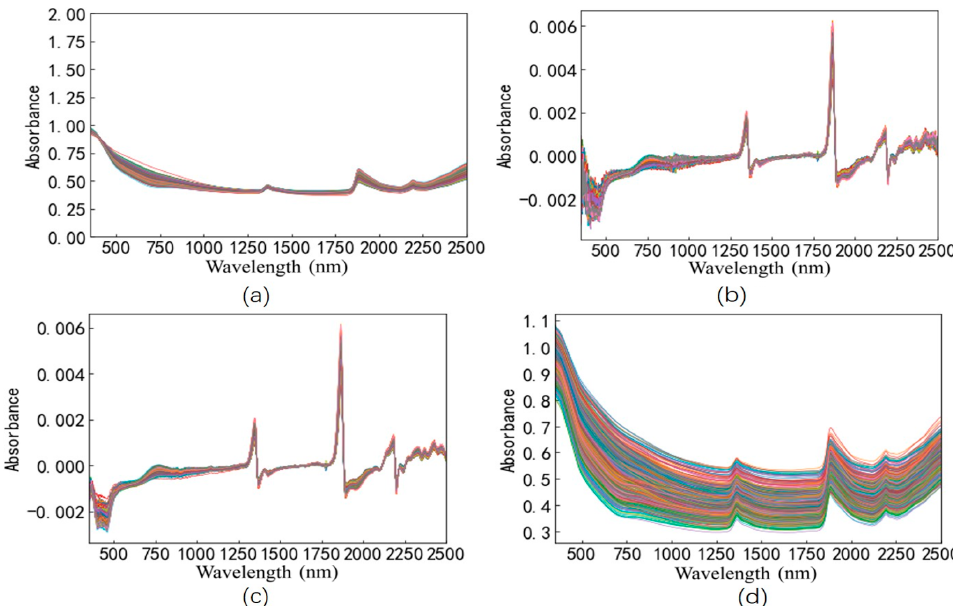
Figure 3. Laboratory vis-NIR after different pre-processing combinations: ( a ) ABS+MSC+SG, ( b ) ABS+FD, ( c ) ABS+SG+FD and ( d ) ABS+SG.